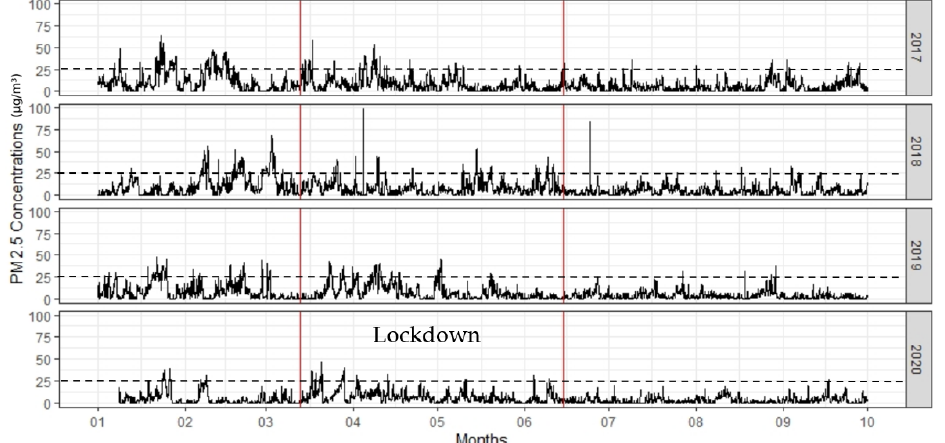
Figure 6. PM 2.5 concentrations from 1 January to 30 September in different years. The red lines delimitate the lockdown period for 2020, from 13 March to 15 June. The dashed line: PM 2.5 limit value in